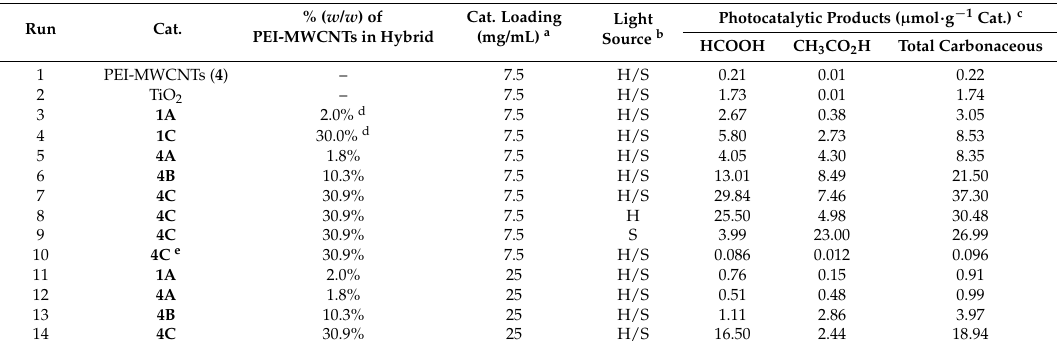
Table 5. Catalytic performance of TiO 2 @PEI-MWCNT hybrids in the photoreduction of CO 2 .